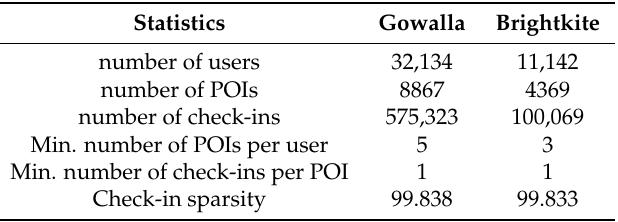
Table 1. Statistics of user-POI check-in